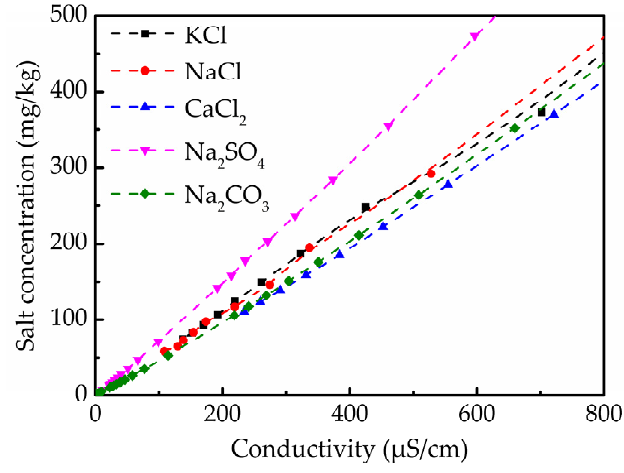
Figure 2. Calibration between salt concentration and conductivity at ambient temperature and pres- sure